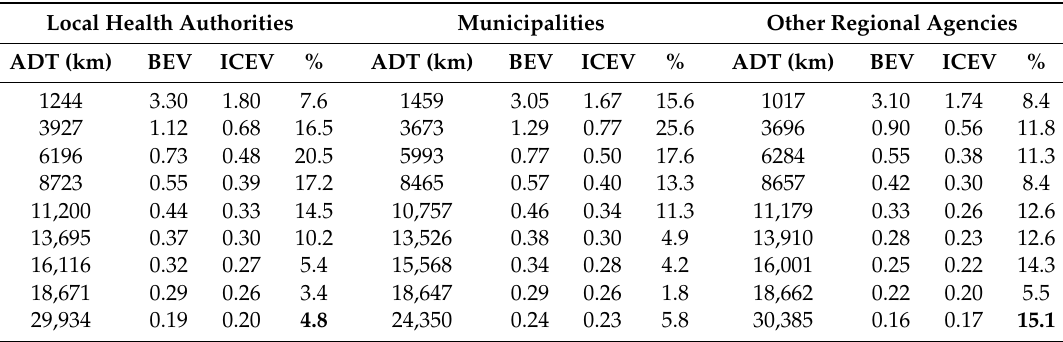
Table 5. TCO estimates for passenger cars with varying ADT: Status quo scenario